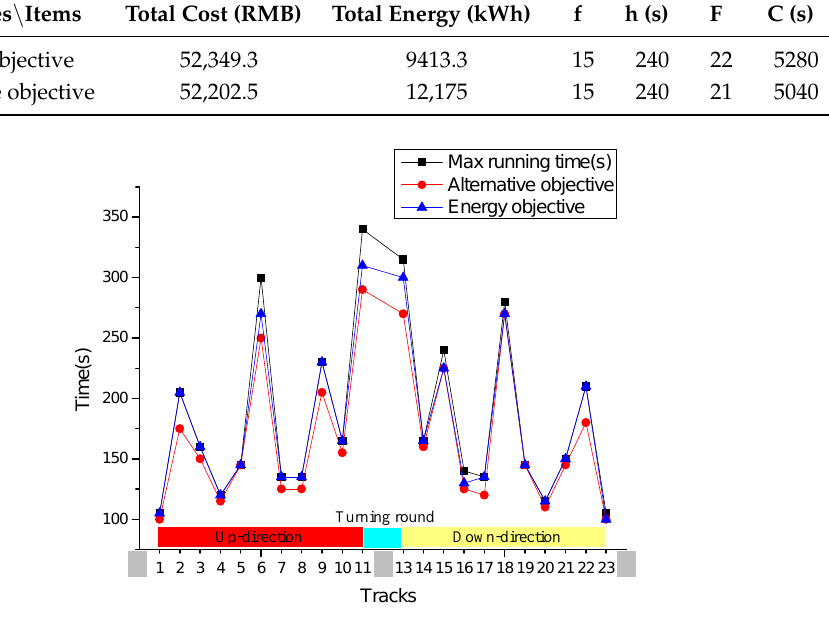
Figure 13. Running time with two different